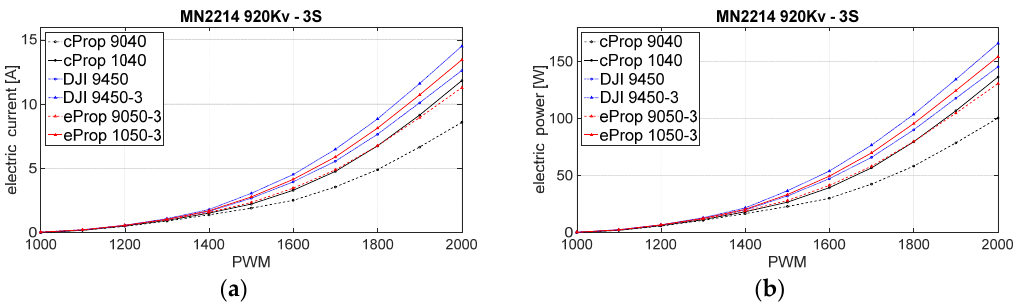
Figure 13. Static maps—1806 BLDC series: ( a ) electric current; ( b ) electric power.